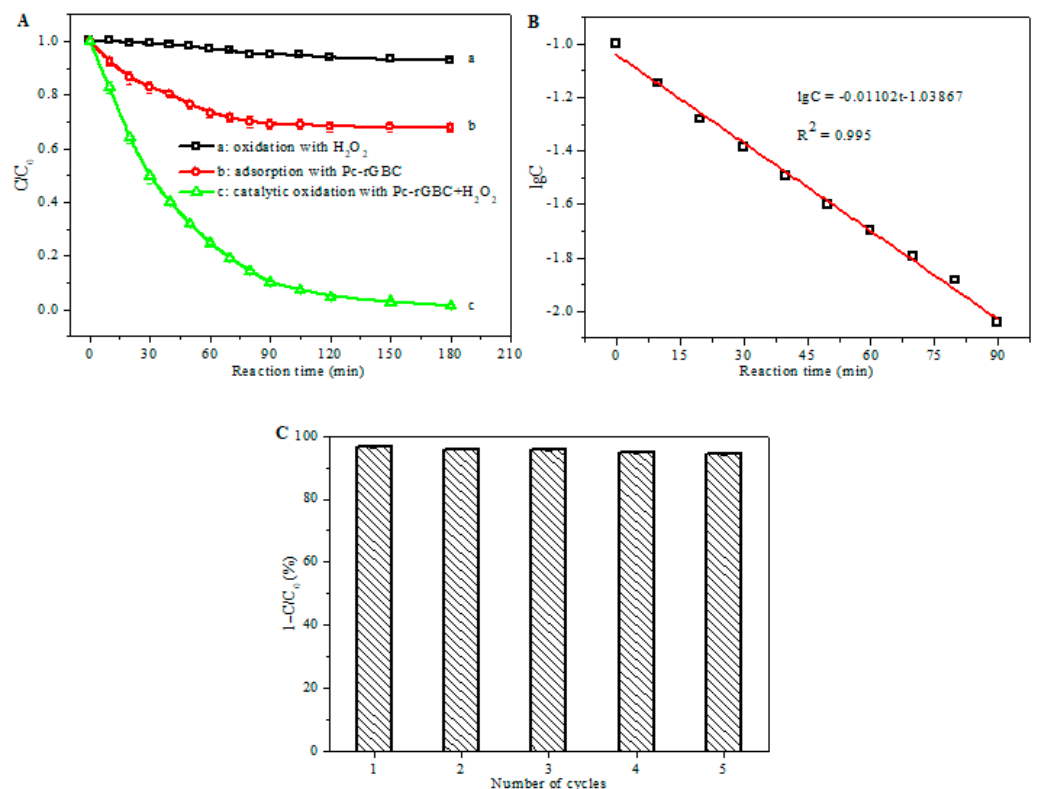
Figure 6. ( A ): Concentration changes of phenol (initial concentration 100 mg/L) under different reaction conditions: a H 2 O 2 (50 mM); b Pc-rGBC (1 mg); c Pc-rGBC (1 mg) and H 2 O 2 (50 mM). ( B ): lgC of H 2 O 2 as a function of reaction time at 50 °C. ( C ): Repetitive catalytic oxidation of phenol (initial concentration 100 mg/L) with Pc-rGBC (1 mg) and H 2 O 2 (50 mM); reaction time = 120 min.